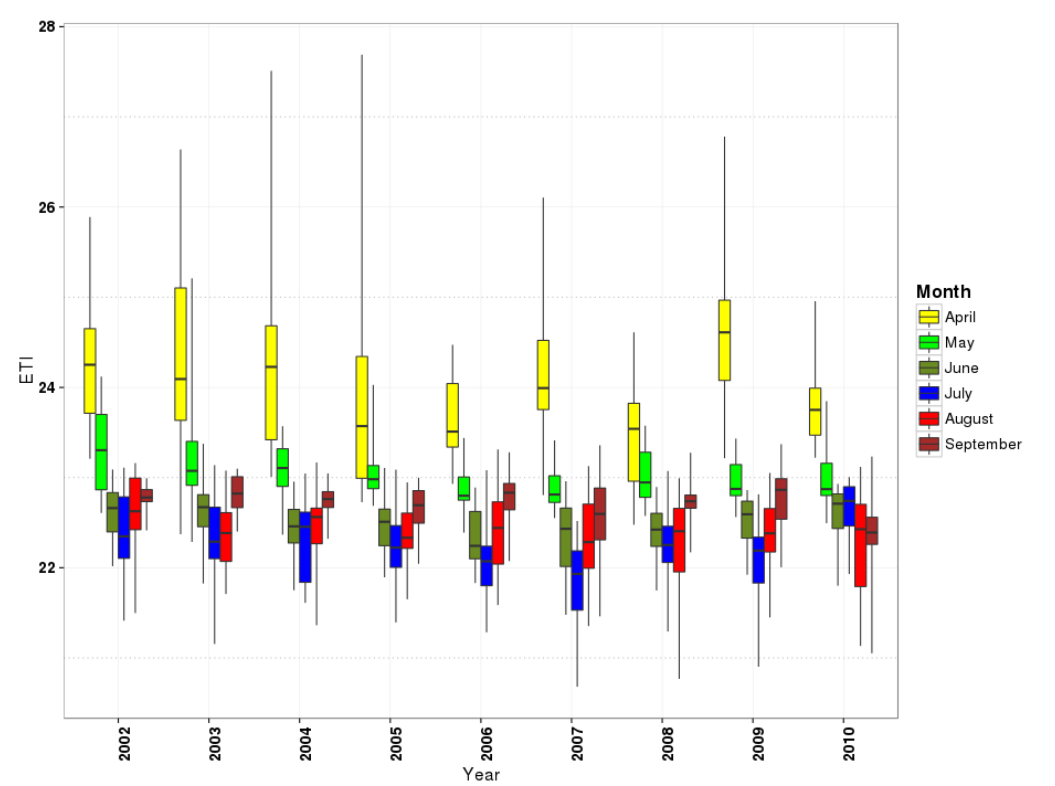
Figure 4. Statistics of climatic parameters from the box plot of T 2m (°C), THI, ETI, from 2002 to 2010 in spring and